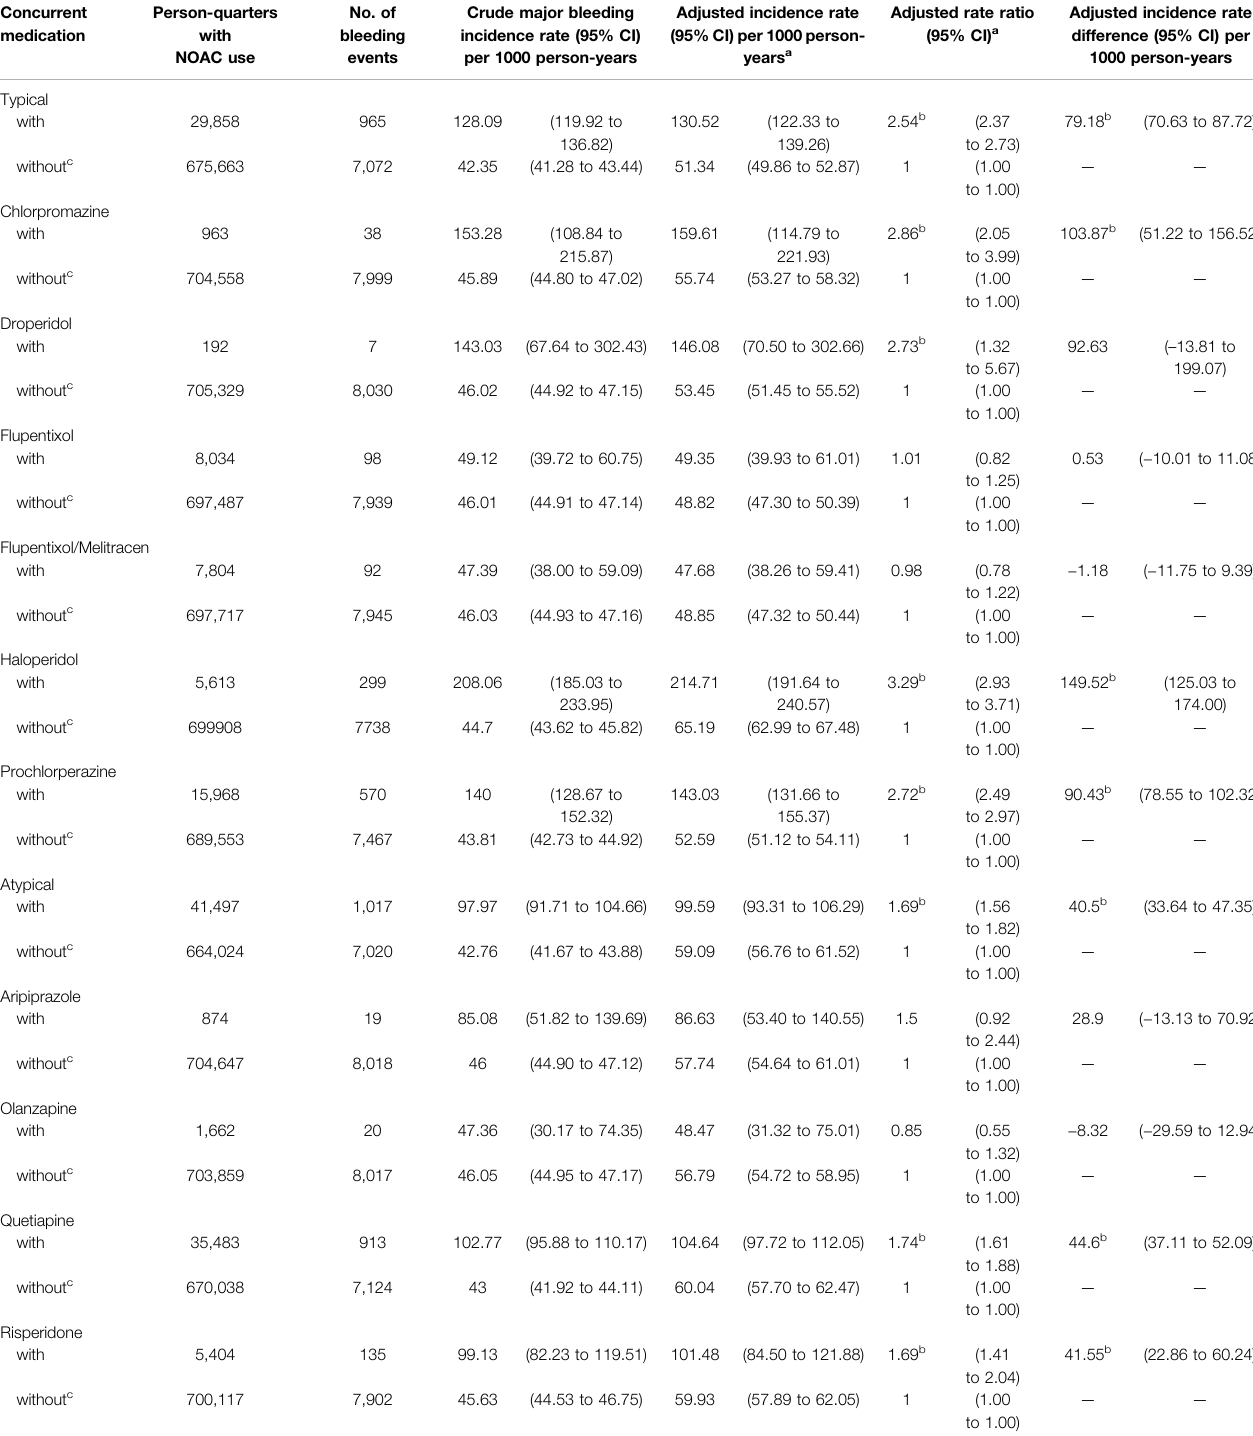
TABLE 3 | Major bleeding risks among AF patients taking non-vitamin K antagonist oral anticoagulants with or without concurrent antipsychotics. Concurrent